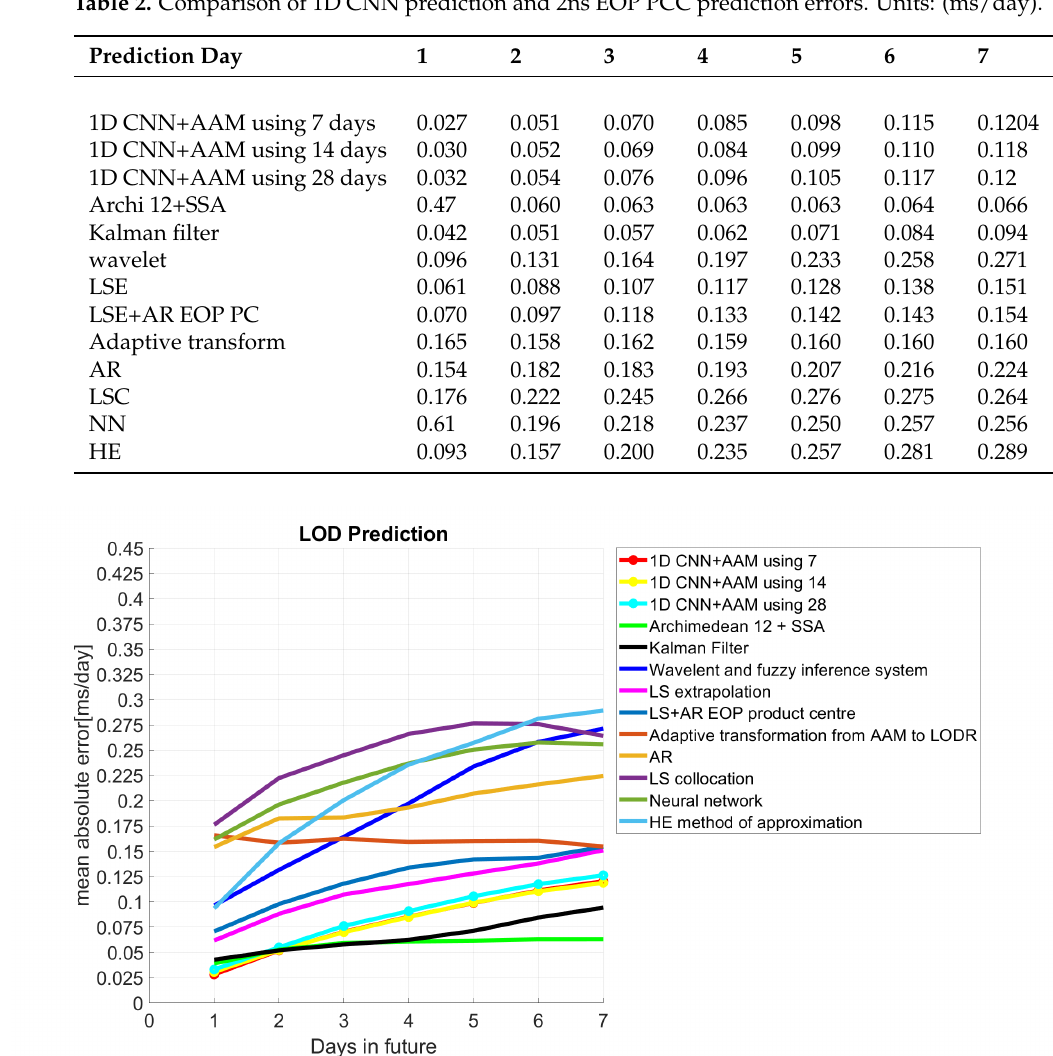
Figure 11. Mean absolute errors of the predicted LOD using the 1D CNN and the 2ns EOP PCC